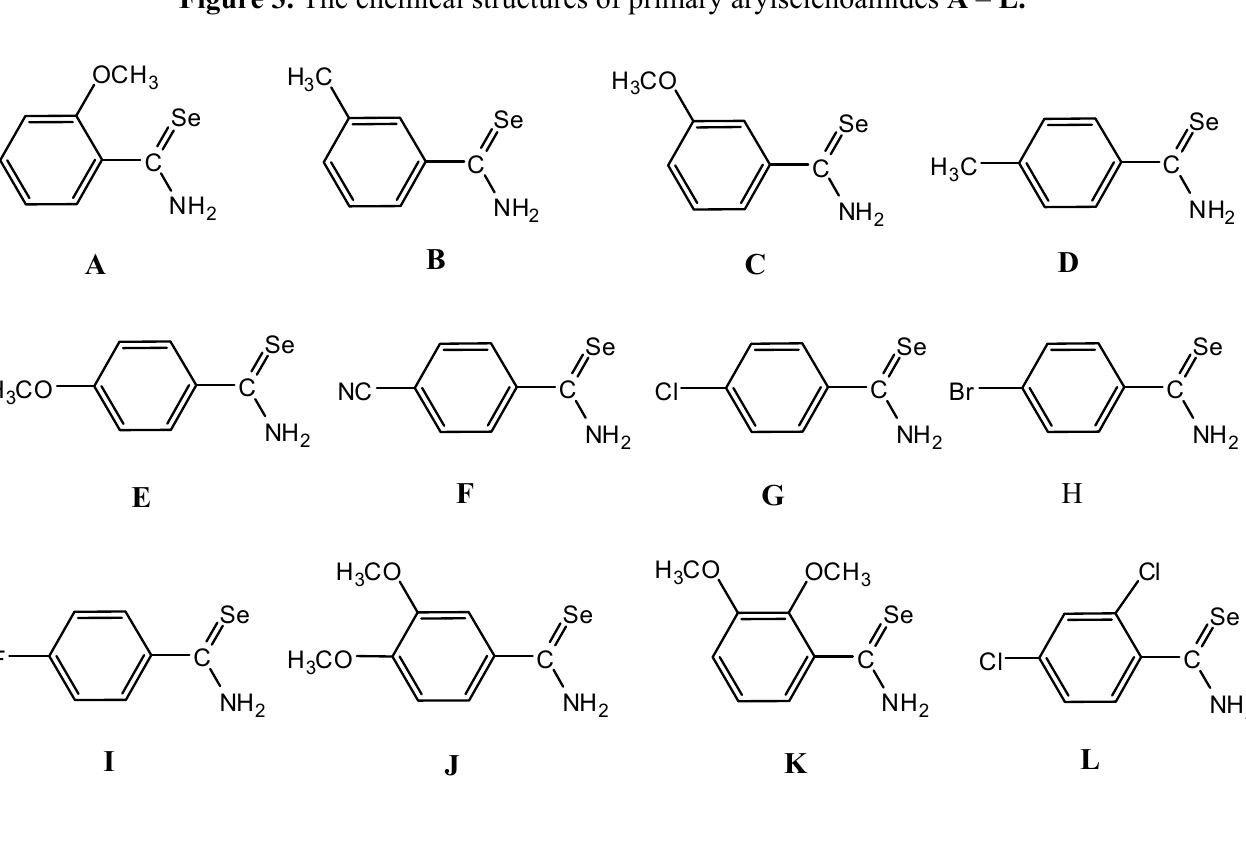
Figure 3. The chemical structures of primary arylselenoamides A –